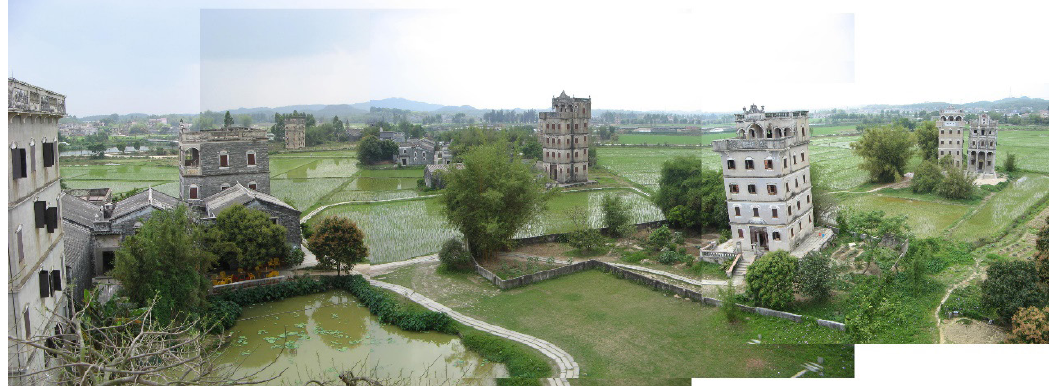
Figure 6. Landscape of Zili village (source: field